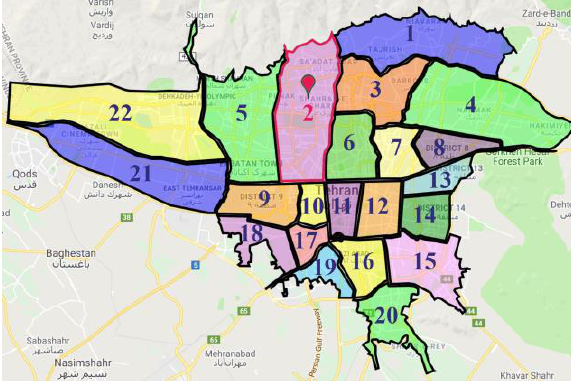
Figure 1. Districts of Tehran and location of district 2 To create a vulnerability map, characteristics of the buildings including the number of floors and the genus of buildings and geophysical specifications of the earth including the Peak Ground Acceleration (PGA) in terms of earthquake magnitude 6.5 in the study area as well as the locations of active faults in the area are used as the parameters affecting the amount of damage to the buildings by the earthquake. Initially, it is necessary to prepare the research data (criteria maps) in order to determine the rate of damage of urban features.  Fault distance layer: The closer the building is to a fault, the more likely it is to be destroyed. As shown in the Figure 2, the farthest distance from the fault in the area is 3780 meters.